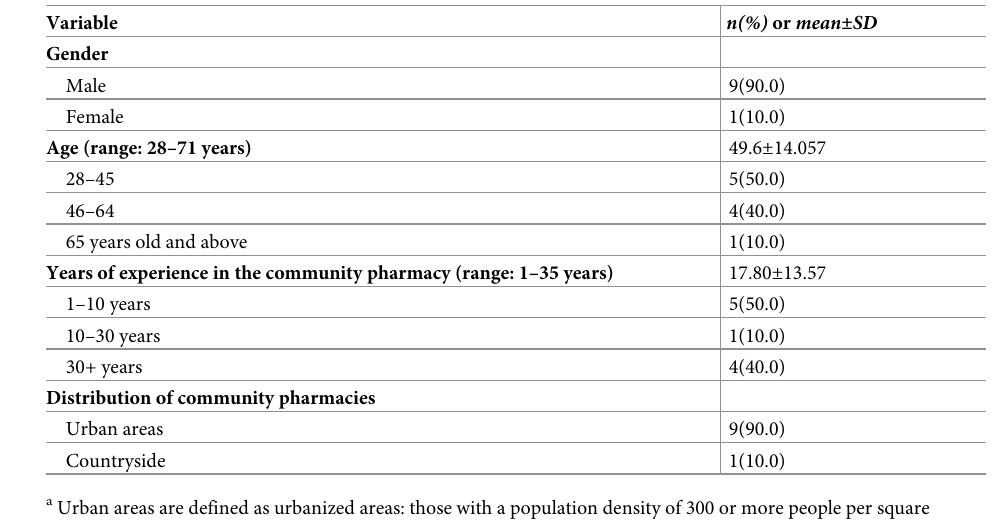
Table 2. Characteristics of pharmacist respondents (n = 10) a .